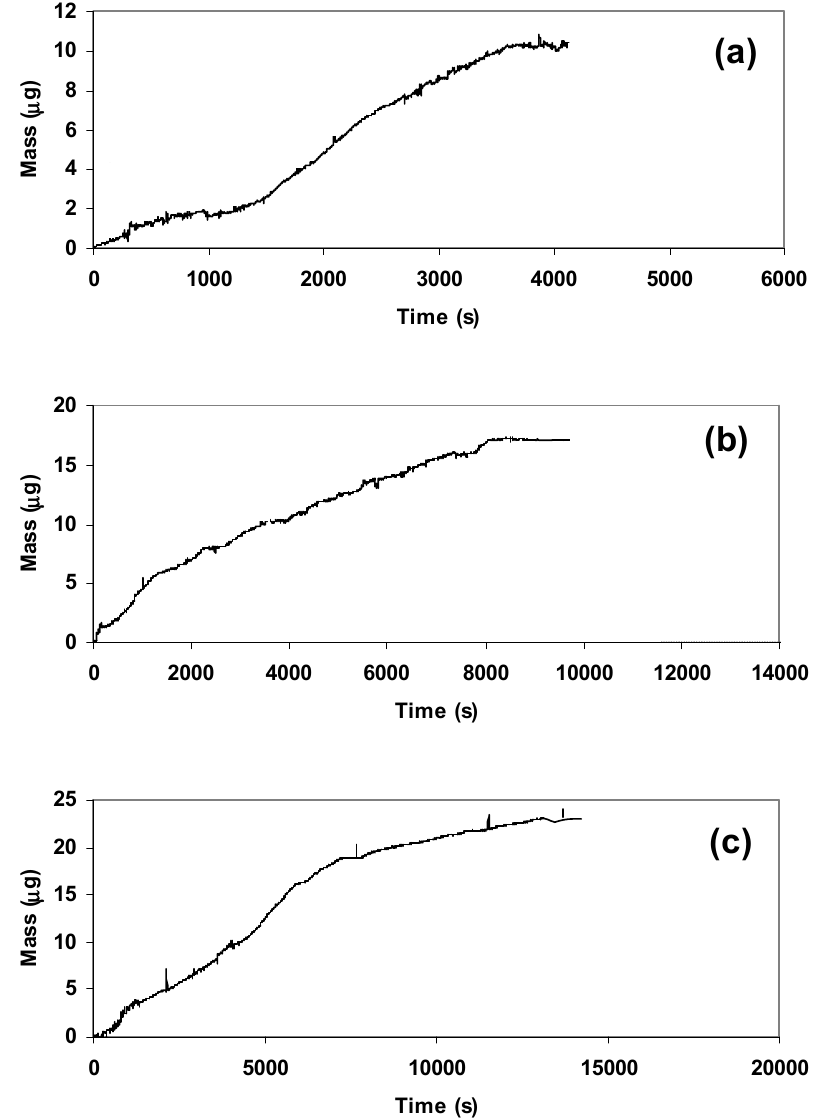
Figure 5. Variation of mass due to carbonation of CaO obtained from different quantities